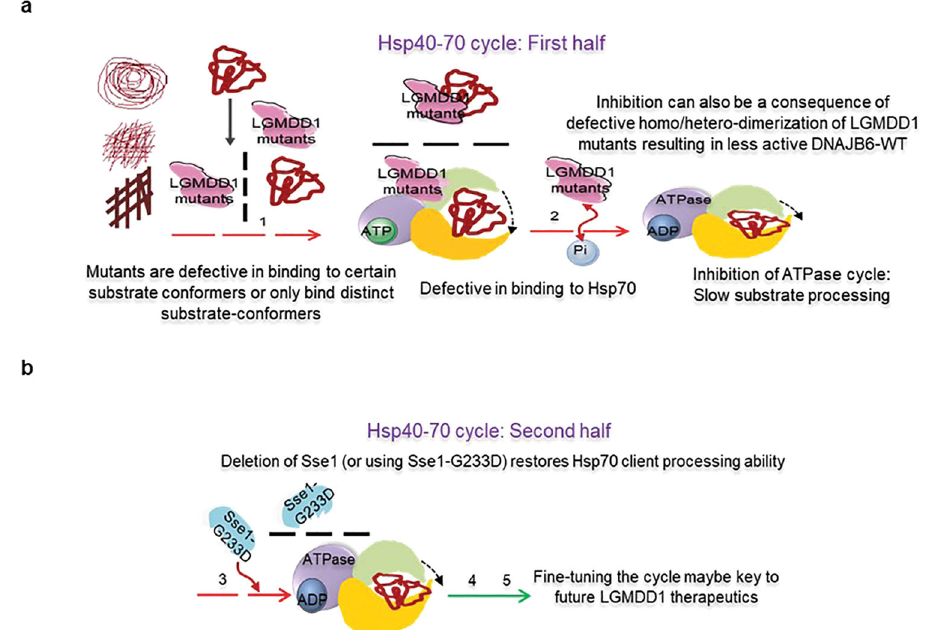
Fig. 8 | Schematicdiagramdepicting possiblemechanismofLGMDD1 mutants and their effects on the Hsp70 ATPase cycle, as well as proposed therapeutic intervention. a Cartoon depicting possible mechanistic insights as to how LGMDD1G/Fdomainmutantsdelayorinhibitthe Hsp70ATPase cycle.Thedashed red arrows indicate inhibition. Mutants were inef fi cient interms of both homo and hetero-dimerizationandthatmayberelatedtotheirreducedabilitytoassistHsp70 in protein folding. In the fi rst half of the Hsp70 ATPase cycle, LGMDD1 mutants were incompetent in their ability to bind speci fi c substrate conformers and Hsp70 (black dashed arrows), which delays the downstream processing of the substrate